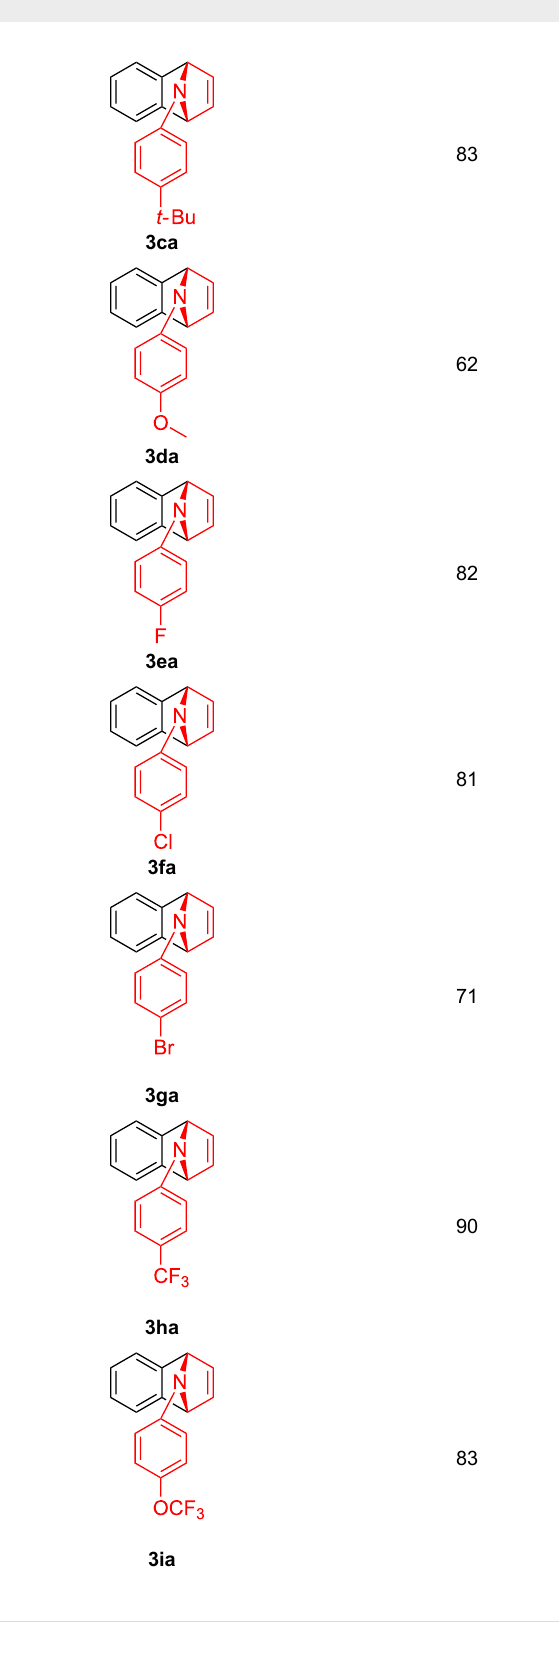
Table 3: Scope of N-substituted pyrroles 1 . a